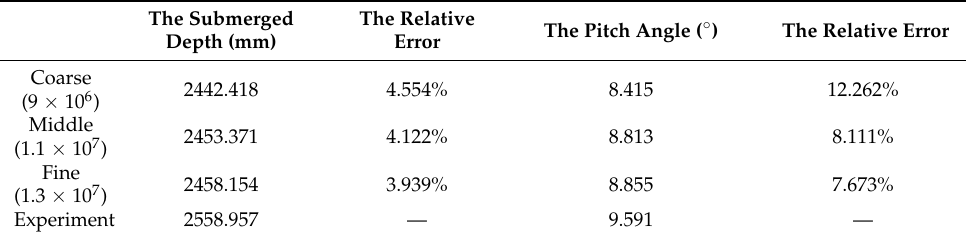
Table 4. The comparison between numerical and experimental results at three sets of